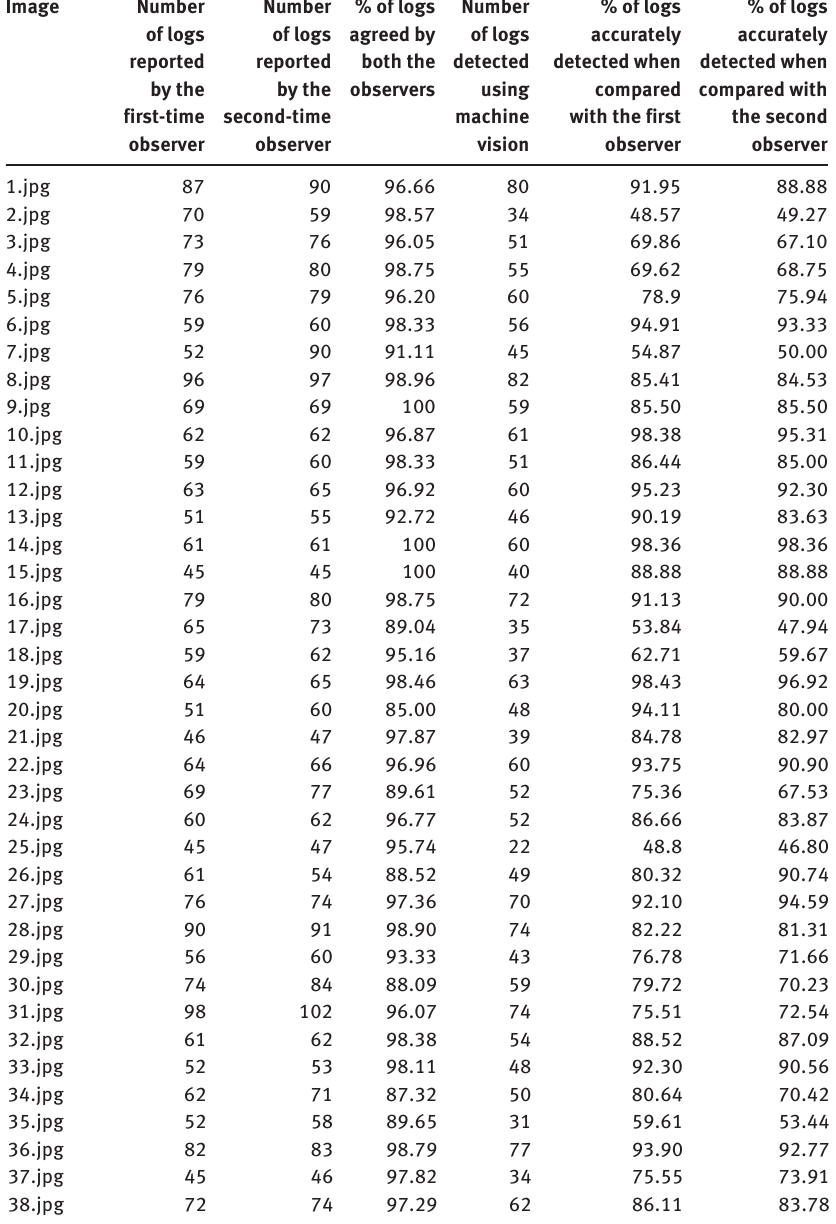
Table 1. Results Achieved by the Machine Vision Algorithm.